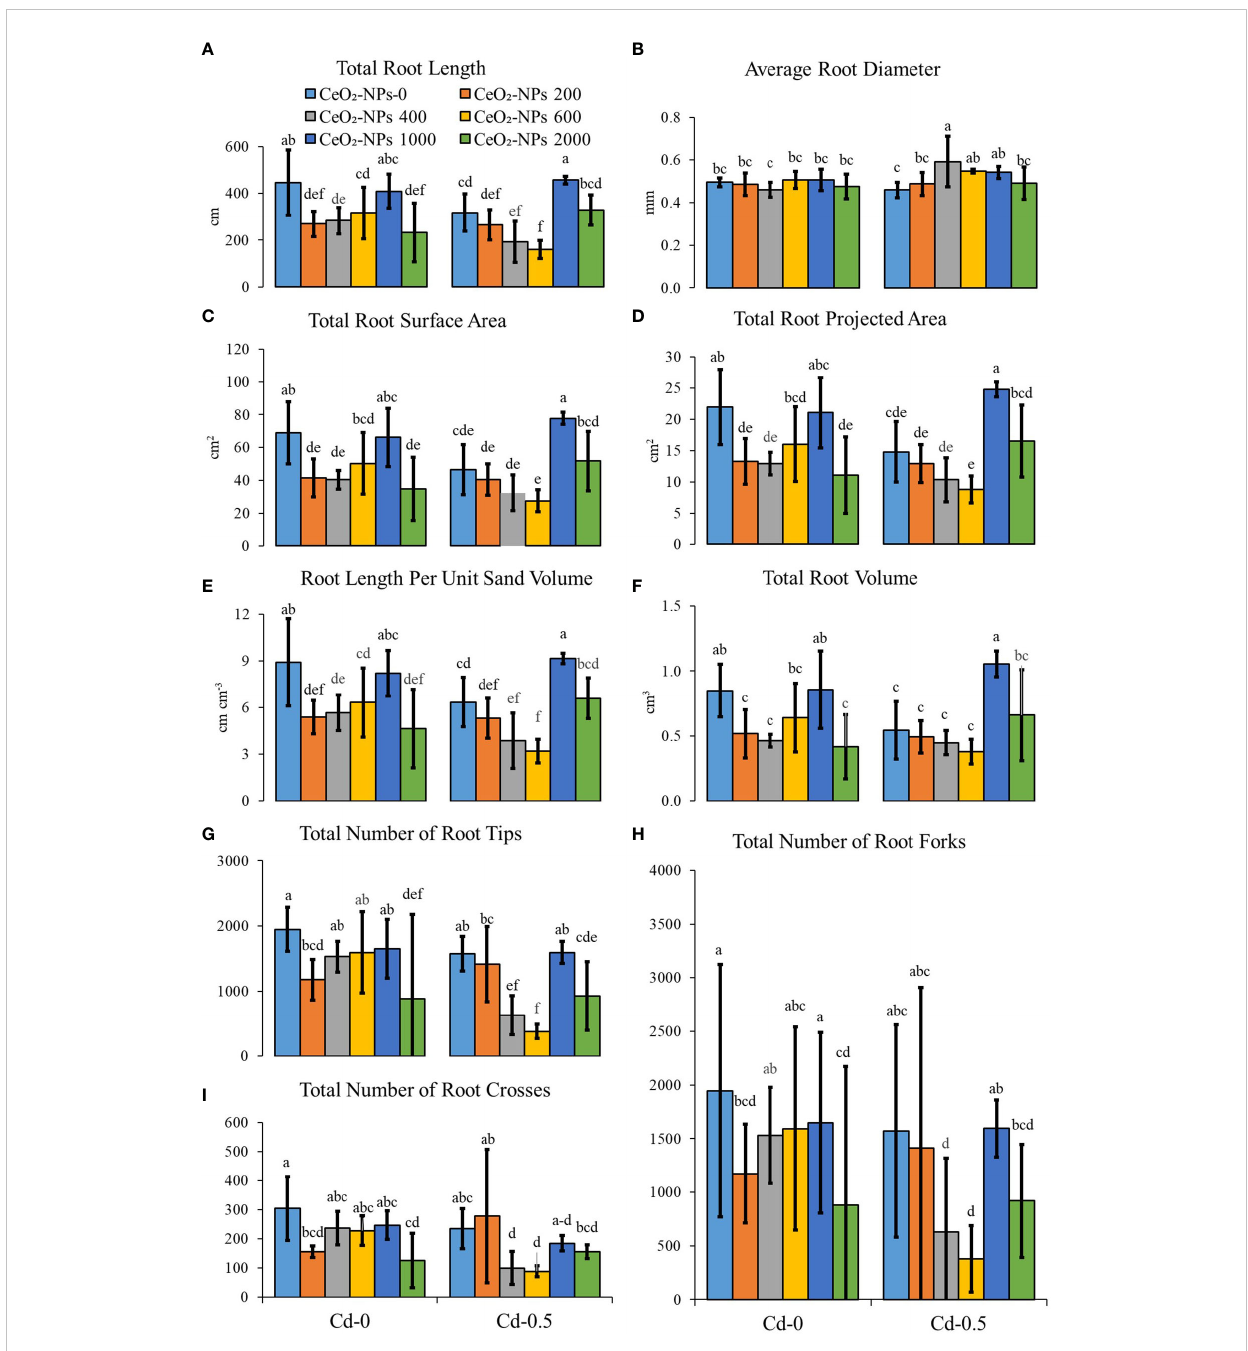
FIGURE 3 Effect of CeO 2 -NPs applied at 200, 400, 600, 1000 and 2000 mg kg -1 dry sand alone and in combination with 0.5 mg kg -1 Cd on maize root growth. (A) total root length (cm), (B) average root diameter (mm), (C) root length per unit volume (cm per cm 3 soil), (D) number of root tips, (E) number of root forks, (F) number of root crosses, (G) total rot surface area (cm²), (H) total root projected area (cm 3 ), (I) total root volume (cm 3 ). The graphs are of mean ( n = 4) ± standard deviation. Letters shown pair wise comparison via Least Signi fi cant Difference (LSD) at p